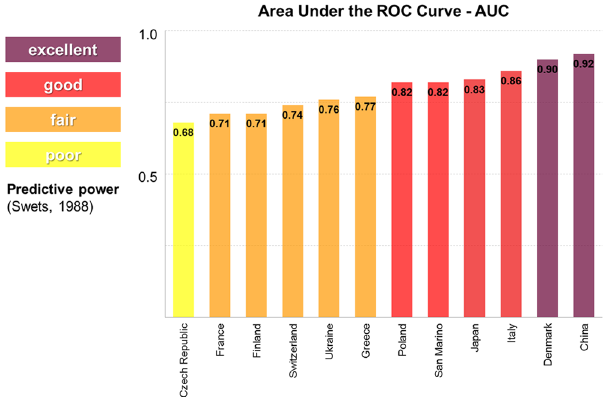
Figure 2. Predictive performance of models using bird species richness as a surrogate of cuckoo occurrence in twelve European and Asian countries. The height of the histogram columns represents the values of the area under the curve (AUC), that is the goodness of fit measure used in this study, indicating how well the model fits a set of observations.